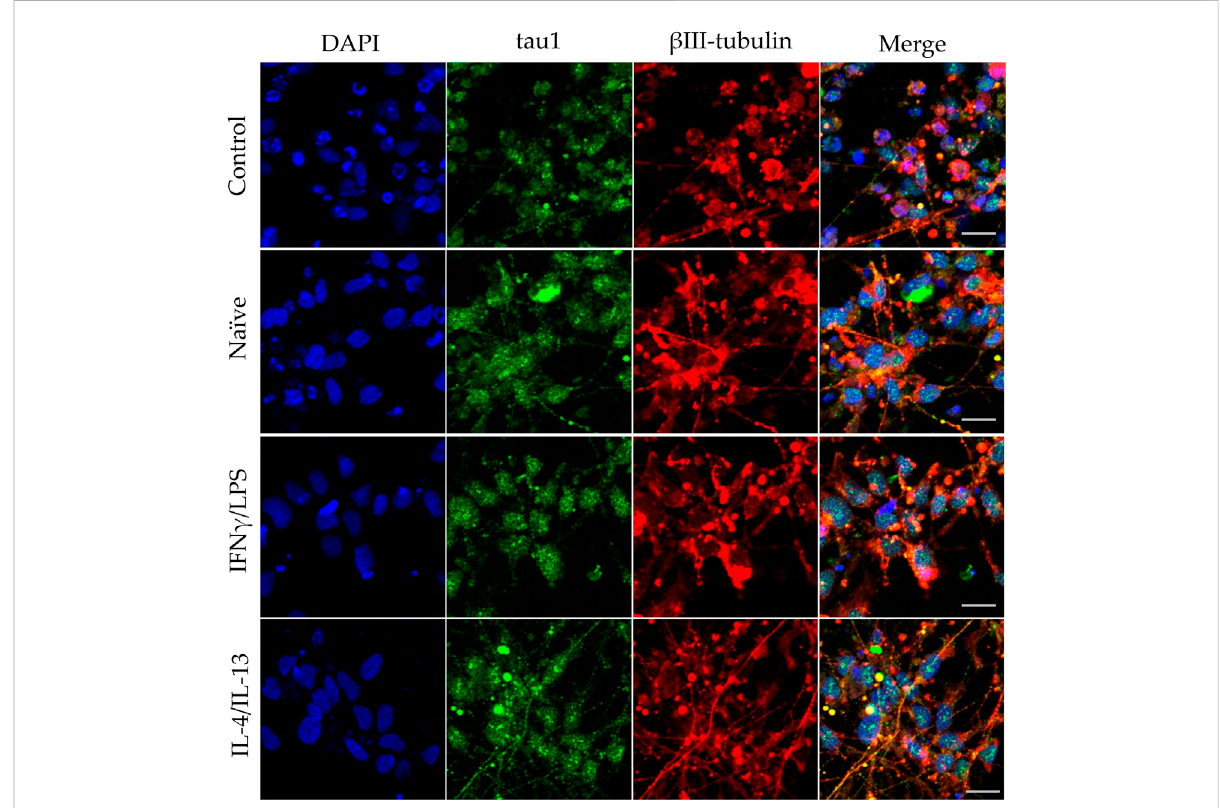
FIGURE 4 Impact of naïve and stimulated microglia on the axon development of differentiating neurons. NPCs were differentiated toward the hippocampal DG granule cells for 18 days. The differentiating neuronal cells were co-cultured with BV2 cells for 4 days (from day 14 to day 18). Microglial cells remained untreated (naïve) or were previously stimulated with an IFN γ /LPS or an IL-4/IL-13 cocktail as indicated. Confocal images depictday18,neuronalculturesimmunostainedfortheaxonalmarkertau1(green)andtheneuronalmarker β III-tubulin(red).Thesampleswere counterstained with DAPI (blue). Scale bars: 25